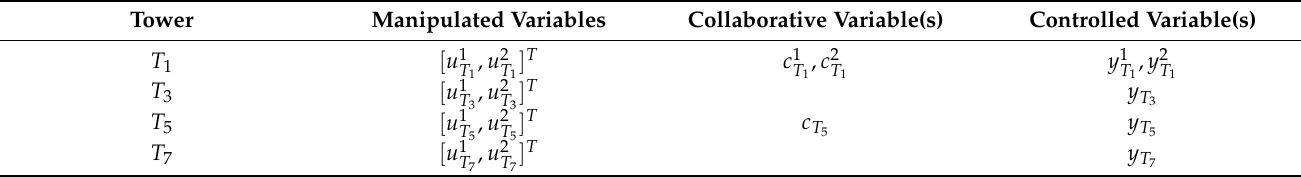
Table 1. Variables in